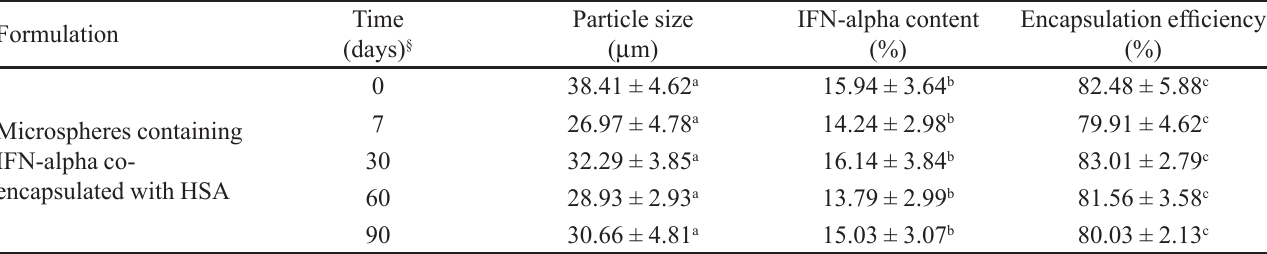
TABLE III - Stability assessment for developed microspheres* #